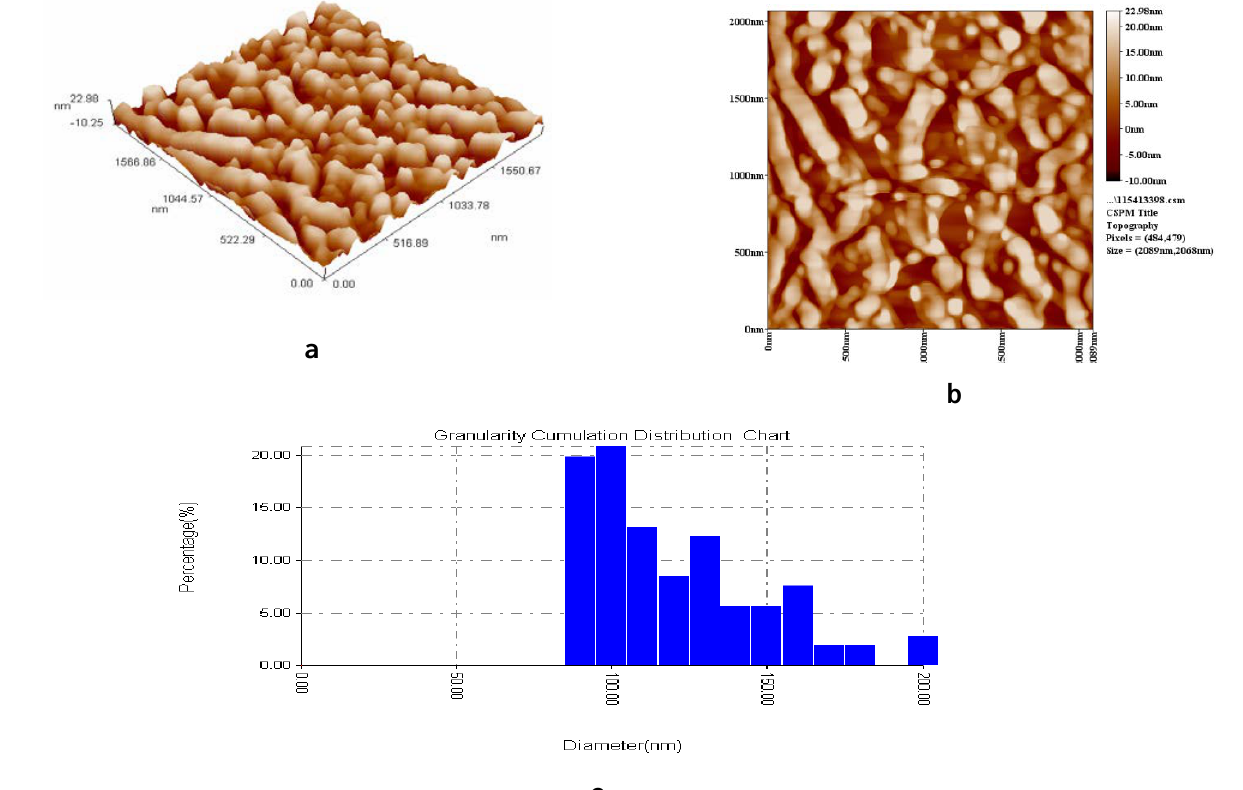
Fig.7: AFM photographs of 11% Ag in PANI/Ag thin film surface a- 3D image b-2 D image and c-size value distribution of PAIN/Ag.